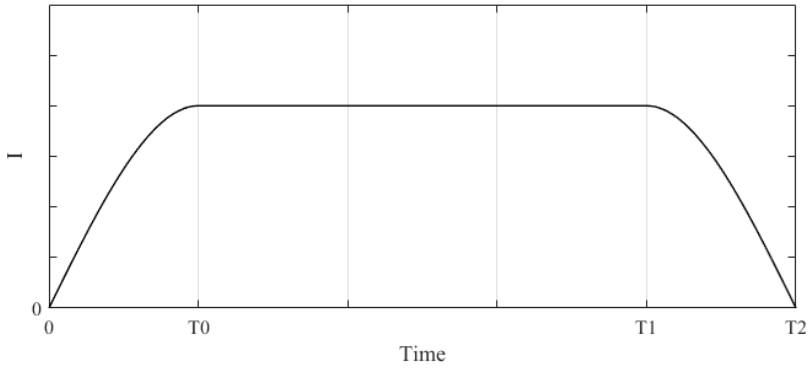
Figure 5. Return-to-Center ( RTC) process.